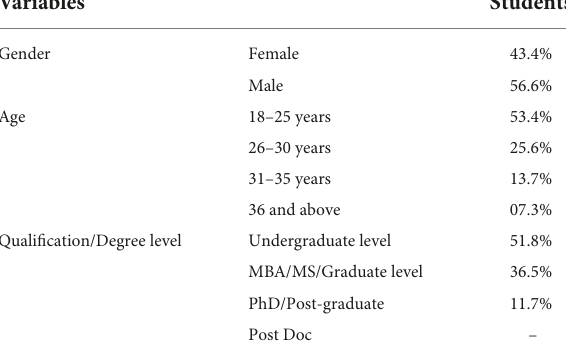
TABLE 1 Respondents’ demographic